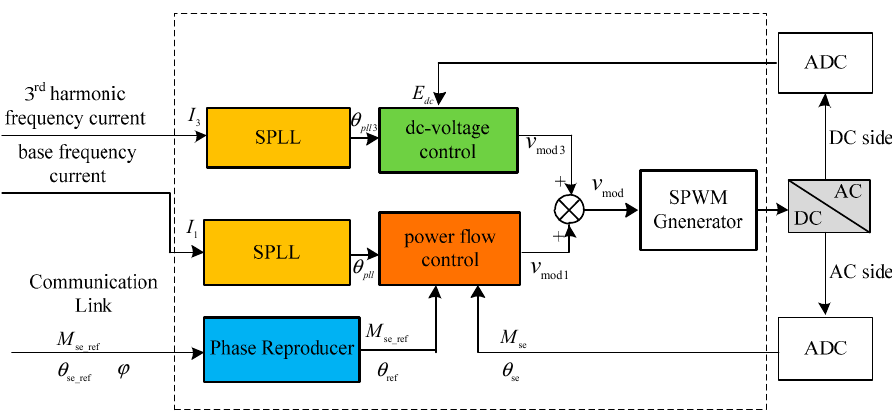
Figure 5. The working principle of the DPFC series unit controller. Single-phase locked loop (SPLL): single-phase locked loop. ADC: analog-to-digital converter. SPWM: sinusoidal pulse-width modulation (PWM).